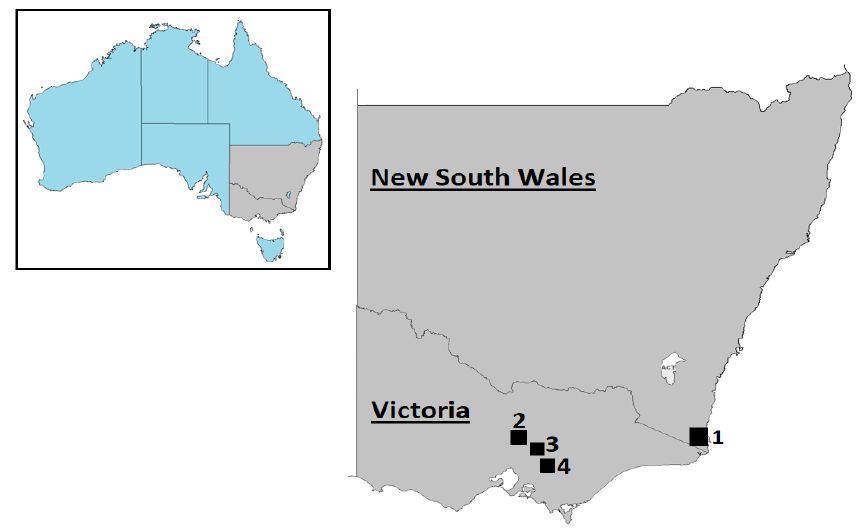
Figure 1. The geographic location of deer (1–4) and cattle (1, 2, and 4) sampling in south-eastern Australia. (1) Kiah, (2) Outer Melbourne, (3) Yellingbo, and (4) Bunyip. ©d-maps.com (accessed 2 August 2021).